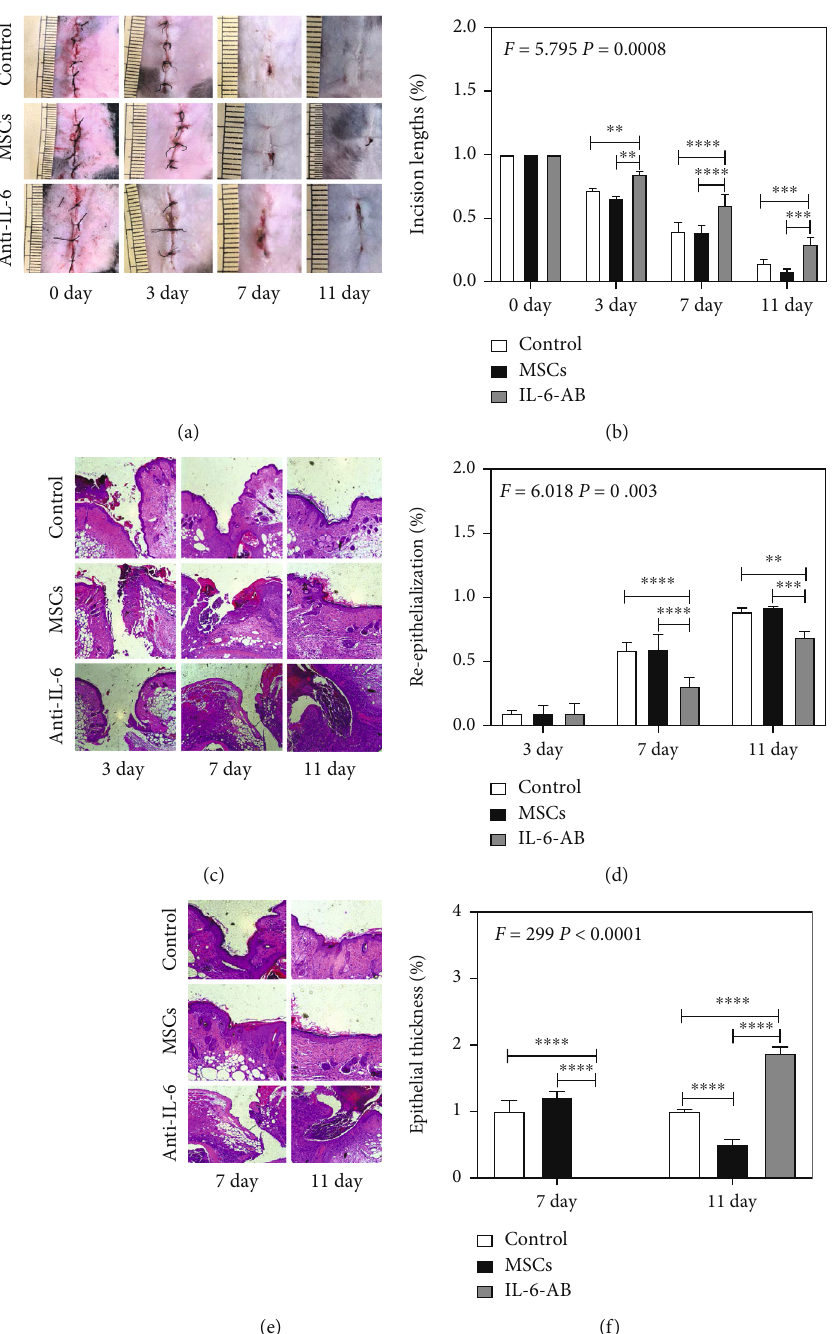
Figure 4: UC-MSCs accelerated surgical wound healing in mice. (a) Representative photographs for the progression of surgical wound healing from days 0 to 11. (b) The statistical results of incision length. (c) H&E staining images of tissues at days 3, 7, and 11 after surgical wound. (d) The statistical results of the epidermal depth. (e) H&E staining images of tissues at days 7 and 11 after surgical wound. (f) The statistical results of the thickness of the neoepidermis. N = 3 in each group; scale bar, 100 μ m ( ∗∗ p < 0 : 01 , ∗∗∗ p < 0 : 001 , ∗∗∗∗ p < 0 : 0001